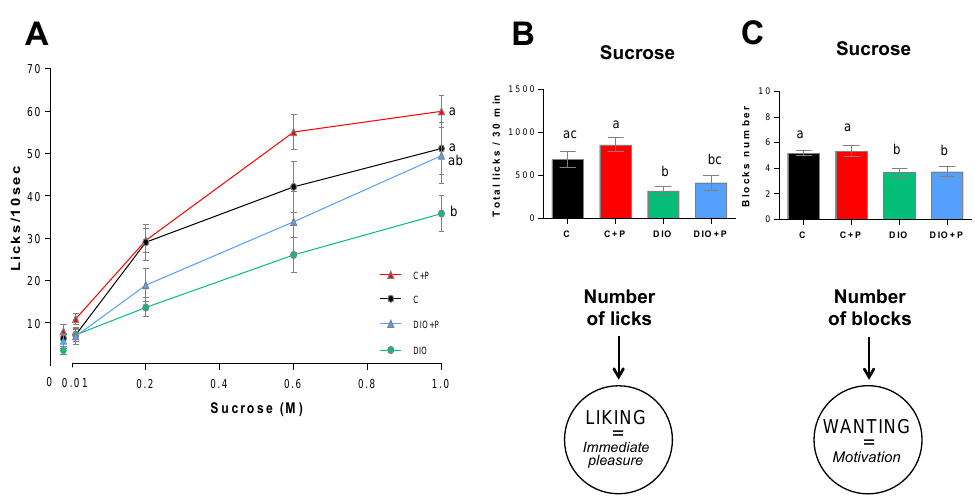
Figure 5. Gustometer analysis of orosensory perception in response to various concentration of sucrose in mice subjected to a regulatory chow or an obesogenic diet alone (C and DIO) or supplemented with 10% Prebiotic (C+P and DIO+P). ( A ) Brief-access taste testing responses (licks/10 s) of naïve mice to control solution (0.3% xanthan gum in water) and ascending concentrations of sucrose (0.01, 0.3, 0.6, 1.0 M). Random access to bottles was computer controlled. Zero on the x-axis represents the licking rate obtained in response to the control solution; ( B , C ) Total number of licks (representative of the “Liking” component) and number of blocks (representative of the “Wanting” component) performed for 30 min. Mean ± SEM. 2-way ANOVA + Tukey HSD, significance was achieved at p < 0.05. Different letters indicate a statistical difference between groups, ns non-significant, C, C+P, DIO, n = 10. DIO+P, n = 8.